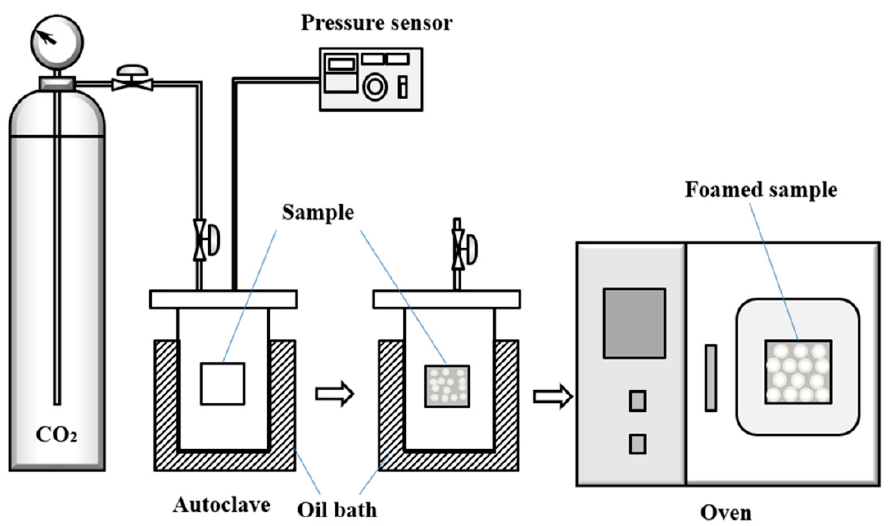
Figure 1. Diagram of CO 2 foaming silicone rubber devices.